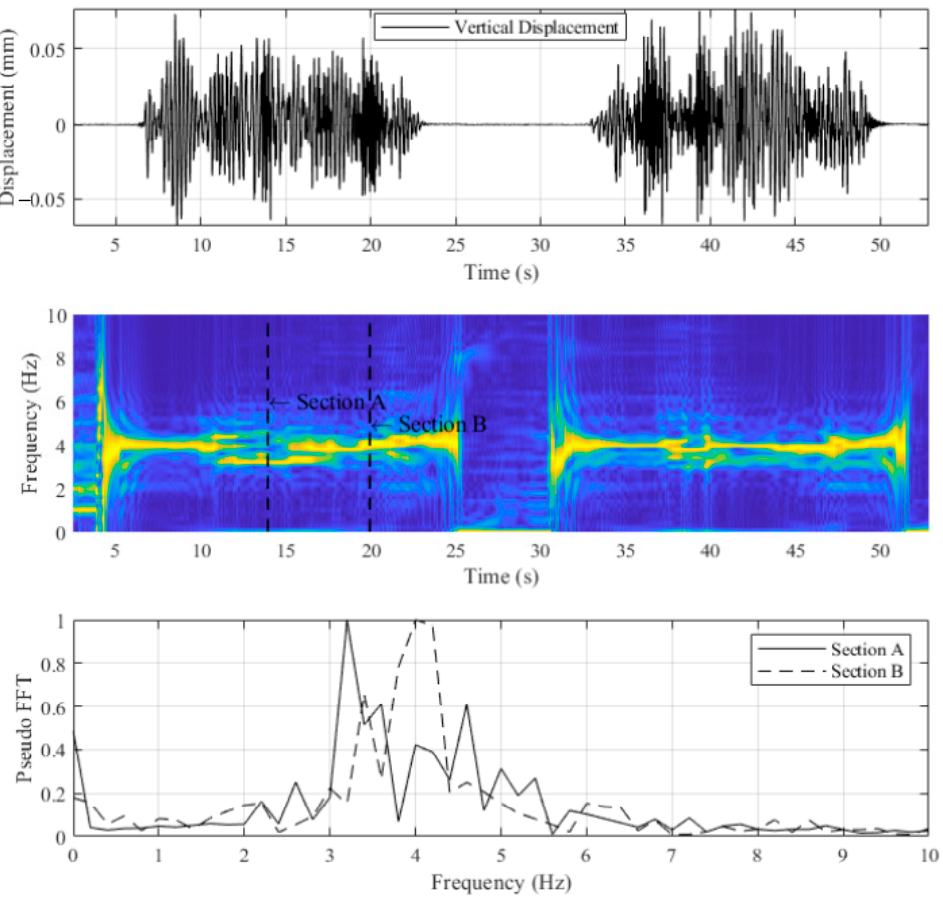
Figure 12. Windowed fast Fourier transform (FFT) of LVB0S1.